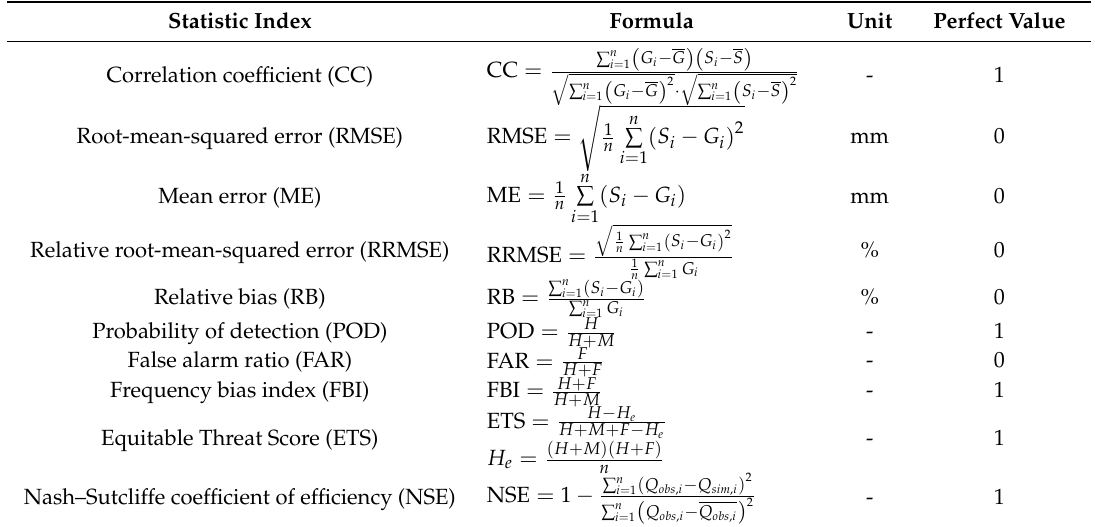
Table 2. List of the validation statistical metrics for evaluating satellite precipitation